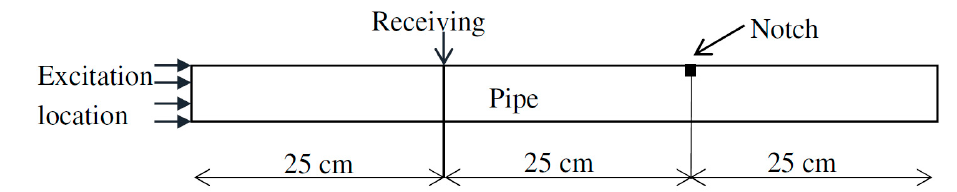
Figure 6. Frequency response of the L(0,2) mode tone-burst wave packet that emitted at a center frequency of 220 kHz and its bandwidth after traveling10 mm and 1600 mm along the pipe. Figure 7. Schematic diagram of the FEM model representing a pipe with a small notch (crack).